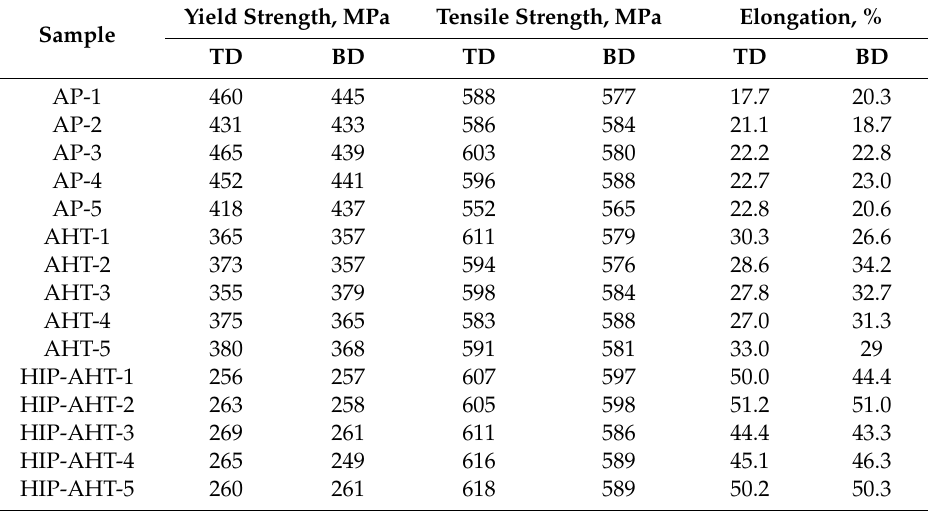
Table A1. Measured mechanical properties along the BD and the TD of the AP, AHT and the HIP + AHT